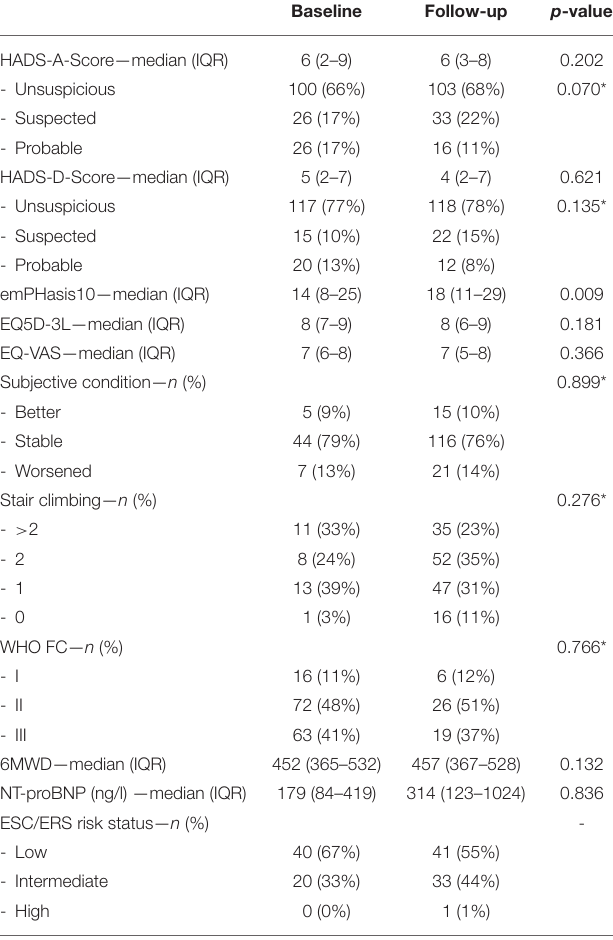
TABLE 2 | Comparison of psychological, clinical parameters and HRQoL. Baseline